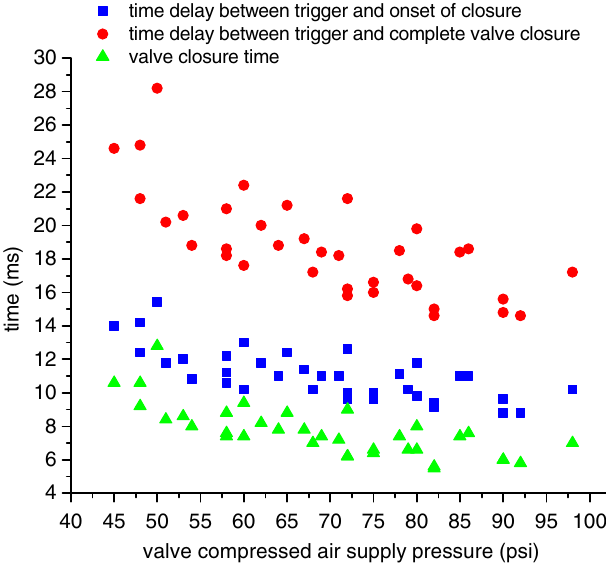
FIG. 5. (Color) Valve closure time versus valve supply pressure. The blue squares show the time delay between valve trigger and the onset of closure, the red circles display the time delay between valve trigger and complete valve closure, and the green triangles show the difference between the two (valve closure